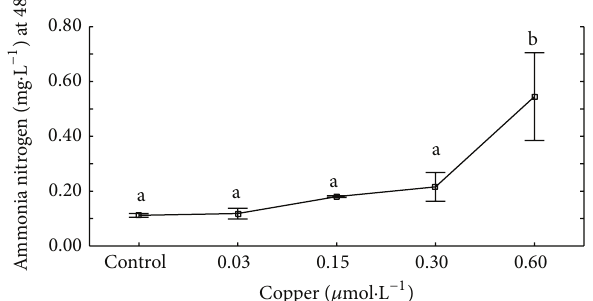
Figure 3: Ammonia levels in seawater after 48h of copper exposure at different concentrations. Different letters show means with significant differences ( 𝑃 < 0.05